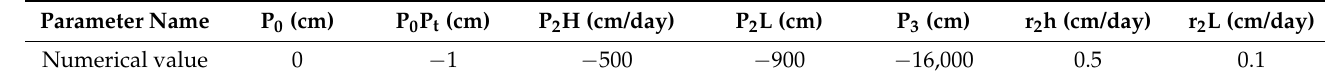
Table 3. Water absorption parameters of winter wheat